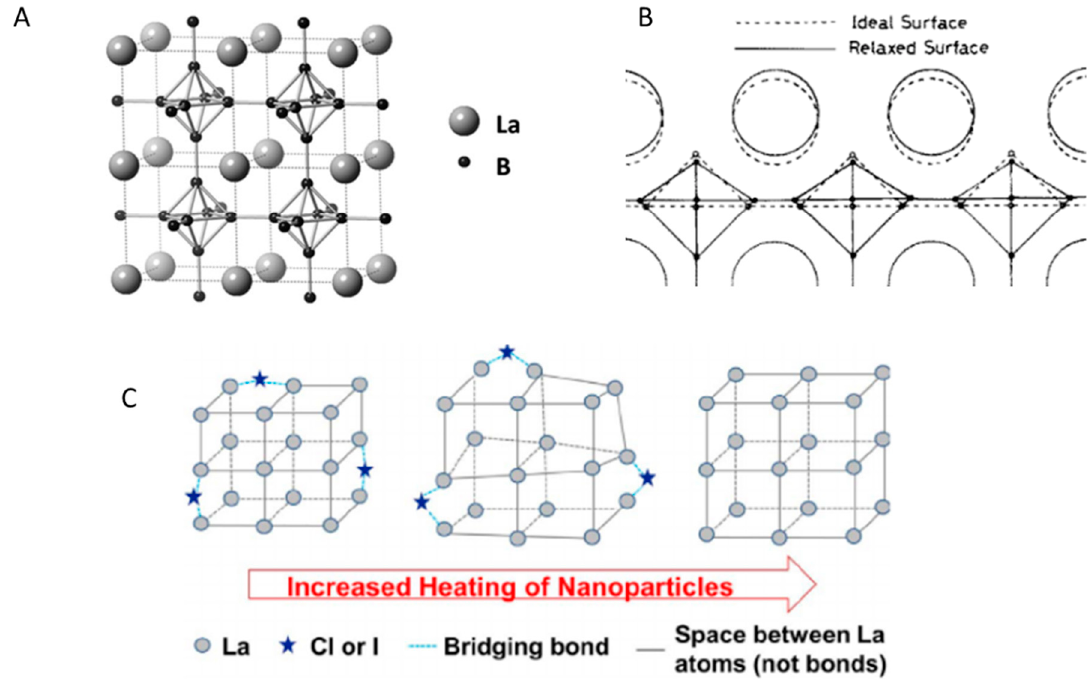
Figure 2. ( A ) Four unit cells of lanthanum hexaboride (LaB 6 ) with a lattice constant of approximately 4.15 Å (reprinted from [48]). ( B ) Position of La (circle) and B 6 (diamond) in relaxed and ideal states on LaB 6 surface (reprinted from [49]). ( C ) Removal of halogen bridge between La atoms with continued heating of LaB 6 nanoparticle (reprinted from [58]).